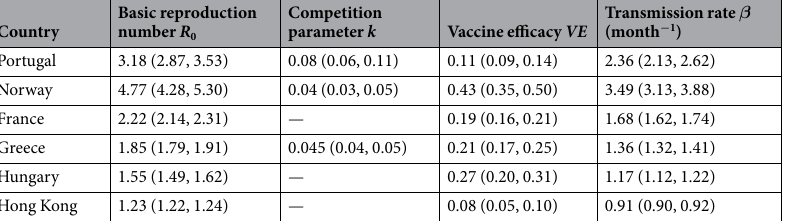
Table 3. Parameter estimates for pneumococcus transmission and PCV7 vaccine efficacy ( VE ) in day care settings. The means and the 95% credible intervals for each parameter are obtained from the posterior distributions. The competition coefficient k is estimated from co-colonization data in some cases, and set to a fixed value in others (—), equal to 0.05, a criterion used to calibrate model initial conditions (see Methods 2). The basic reproduction number is derived as: = β R i ( ) γ μ +